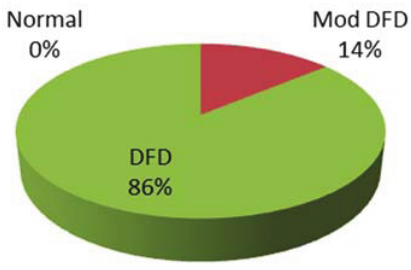
Figure 4. Percent normal, moderate DFD, and DFD meat from poorly-handled cattle.